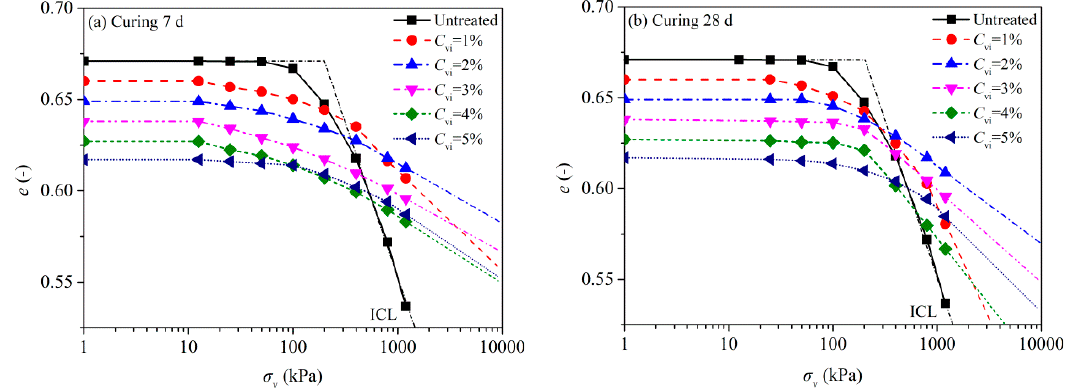
Figure 19. Integrated plot of the e − log σ v relationship of saturated untreated and cement-treated GRSs. ( a ) Curing time = 7 d; ( b ) Curing time = 28 d.